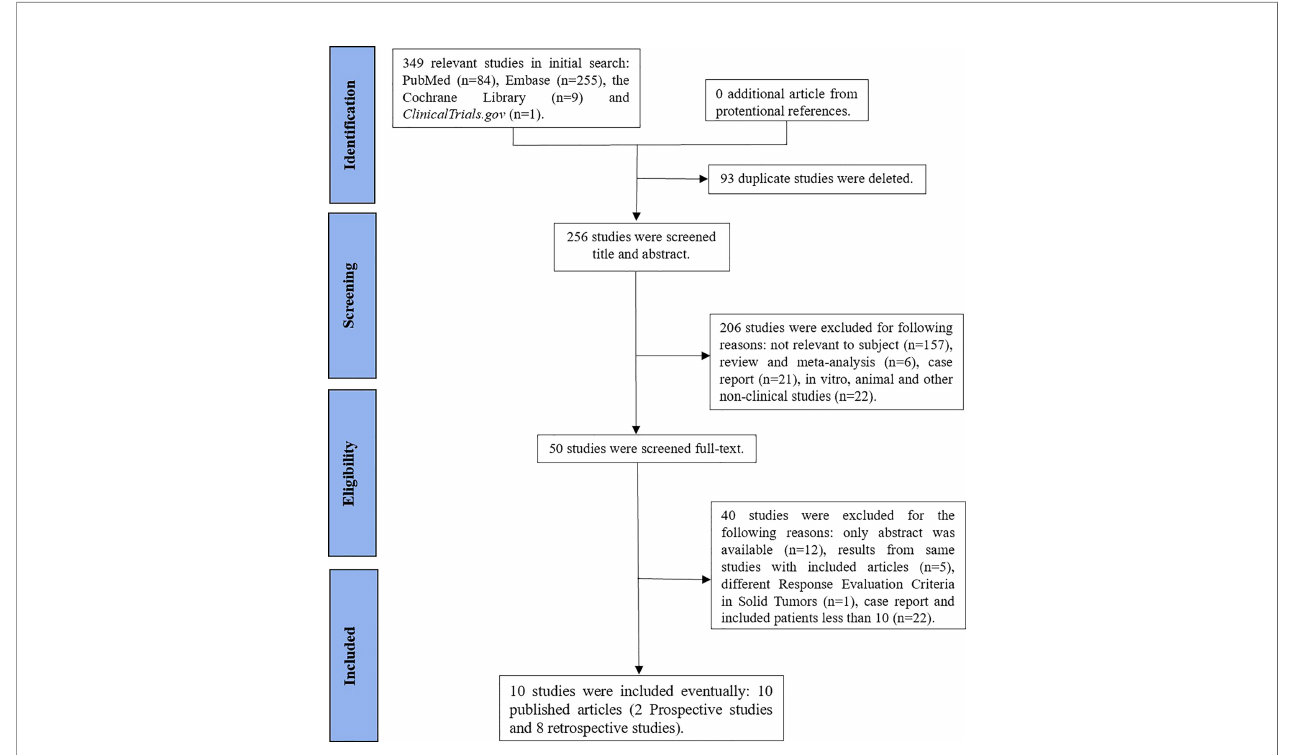
FIGURE 1 | Flowchart of the studies ’ selection